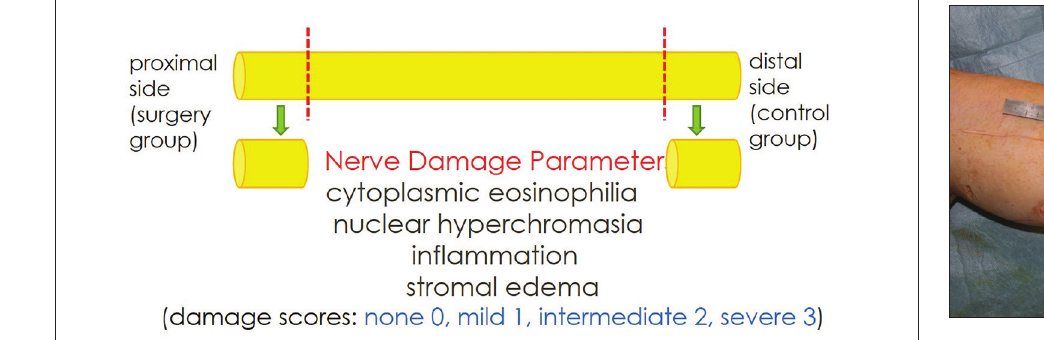
Figure 5. The sural nerve graft of 38 cm could be harvested with this technique.